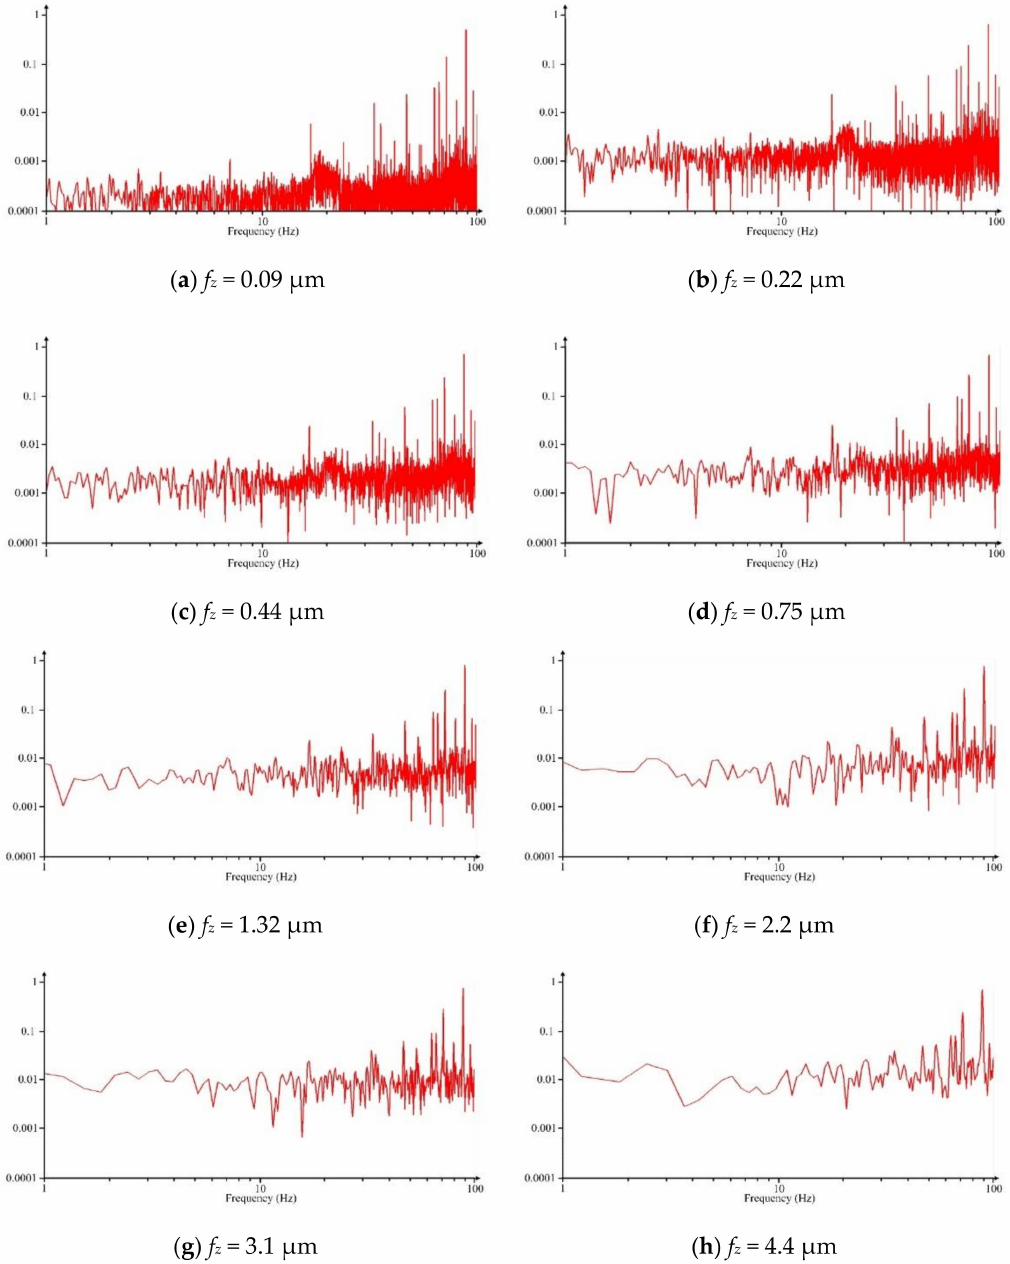
Figure 9. The frequency domain signal at di ff erent feed per tooth ( a p = 5 µ m, n = 16,000 rpm)